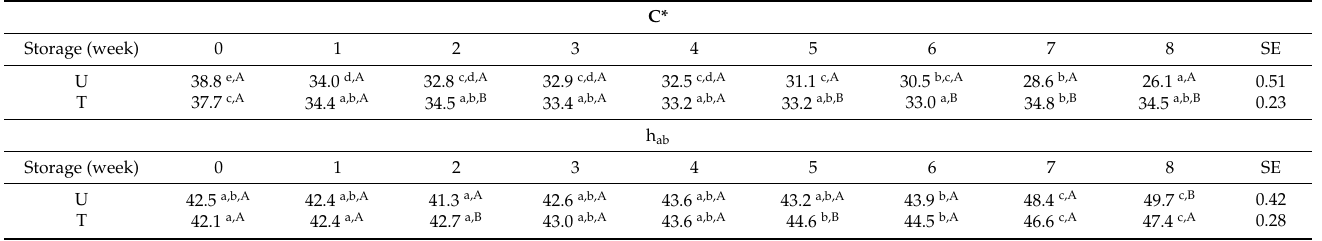
Table 2. The effects of thymol treatment on the chroma (C*) and hue angle (h ab ) values of the sausages refrigerated at 6 °C for eight weeks.